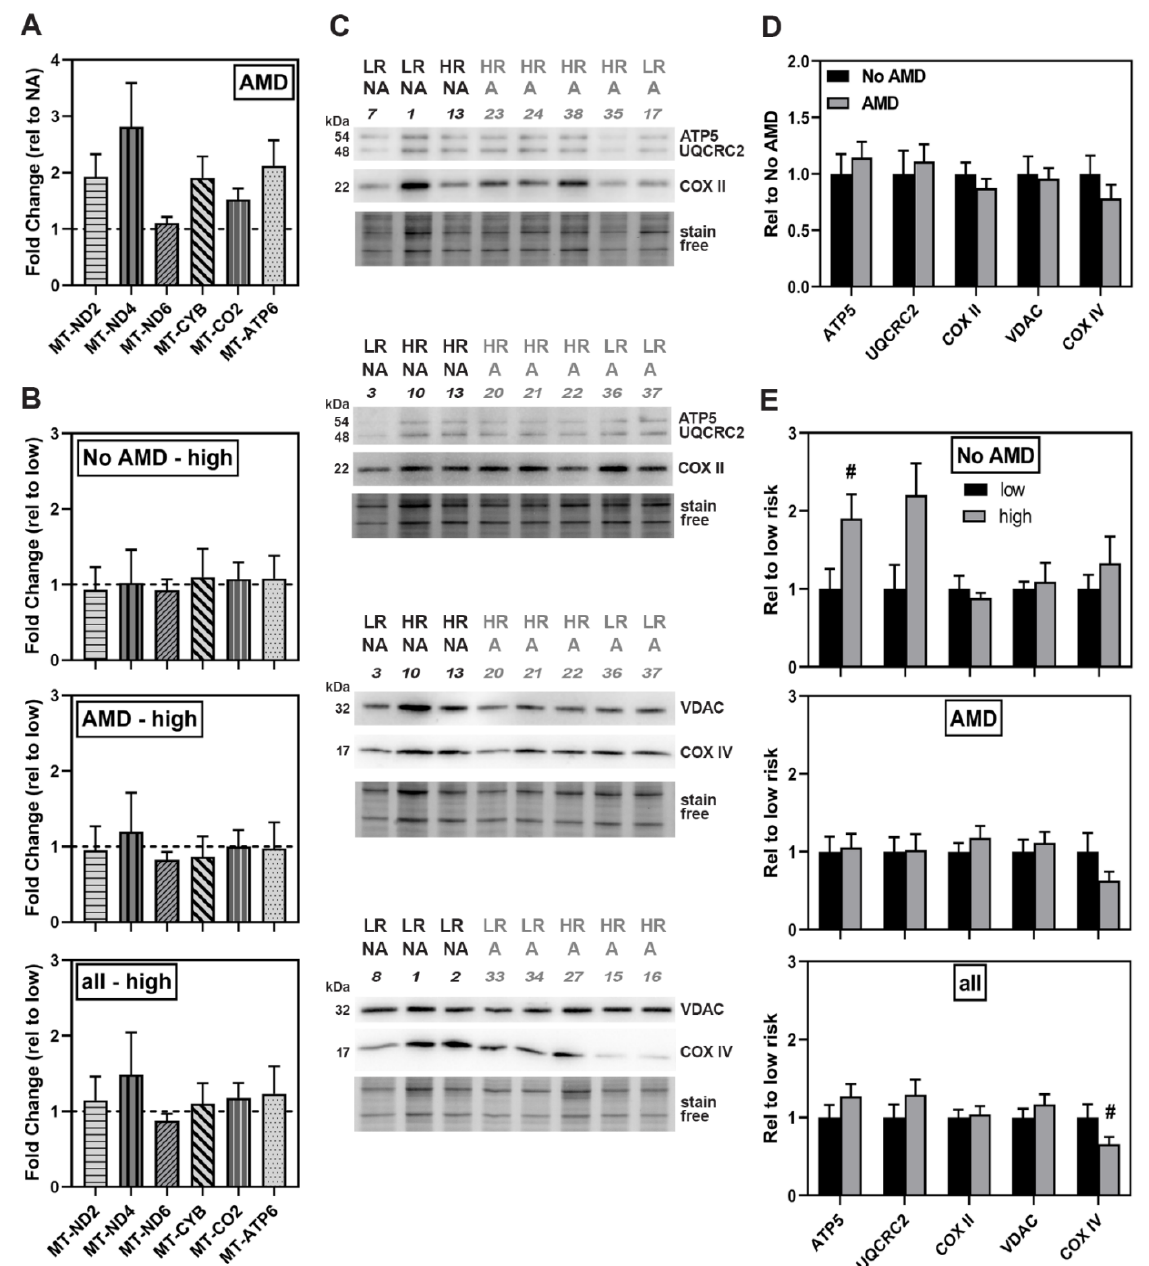
Figure 4. No significant difference in gene expression or content of mitochondrial-related proteins. ( A , B ) Gene expression analysis by qRT-PCR of OXPHOS genes in (A) iPSC-RPE from No AMD (5 donors, 8 lines) and AMD donors (13 donors, 20 lines) or ( B ) CFH low-risk (No AMD 3 donors, 5 lines; AMD 5 donors, 8 lines) and high-risk (No AMD 1 donor, 2 lines; AMD 8 donors, 12 lines). Results are fold-change in expression relative to the average for ( A ) No AMD donors (dashed line) or ( B ) high-risk relative to the average of low-risk samples (dashed line). In ( A ) and ( B ), there were no significant differences as assessed by un-paired t-tests of ∆∆ Ct values. ( C ) Representative image of western blots used to analyze protein content of iPSC-RPE cells. NA = No AMD, A = AMD. LR = low risk, HR = high risk. Numbers correspond with specific donor lines listed in Table 1. Stain free image below blot was used to normalize protein load. ( D , E ) Content analysis of mitochondrial-related proteins in (D) No AMD (7 donors, 9 lines) and AMD (13 donors, 21 lines) iPSC-RPE or ( E ) Low-risk (No AMD 4 donors, 5 lines; AMD 5 donors, 8 lines) and high-risk (No AMD 3 donors, 4 lines; AMD 8 donors, 13 lines). Data were normalized to the mean density for ( D ) No AMD iPSC-RPE or ( E ) low-risk iPSC-RPE. All data are mean ± SEM. # p < 0.1 determined by un-paired t-test. All other comparisons were not statistically different.